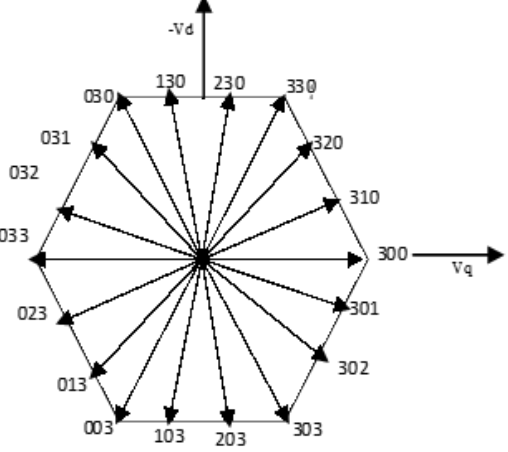
Figure 3. Switching state vectors of the four-level in d - q reference frame [16].